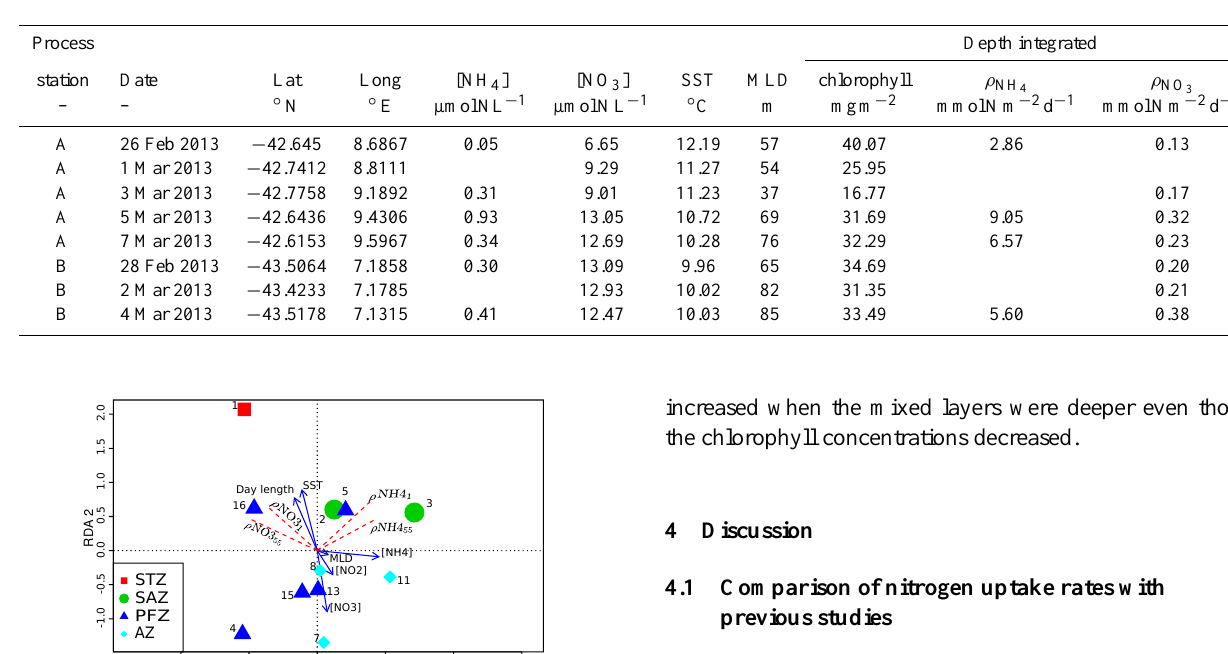
and chlorophyll concentration and associated SST, MLD (mixed layer depth), [NH 4 ] and , ρ NO 4 3